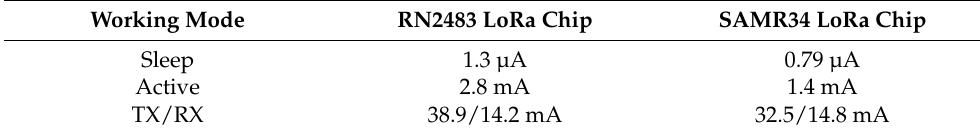
Table 4. Current absorbed by the transceivers of the two EDs employed in this study at 3.3